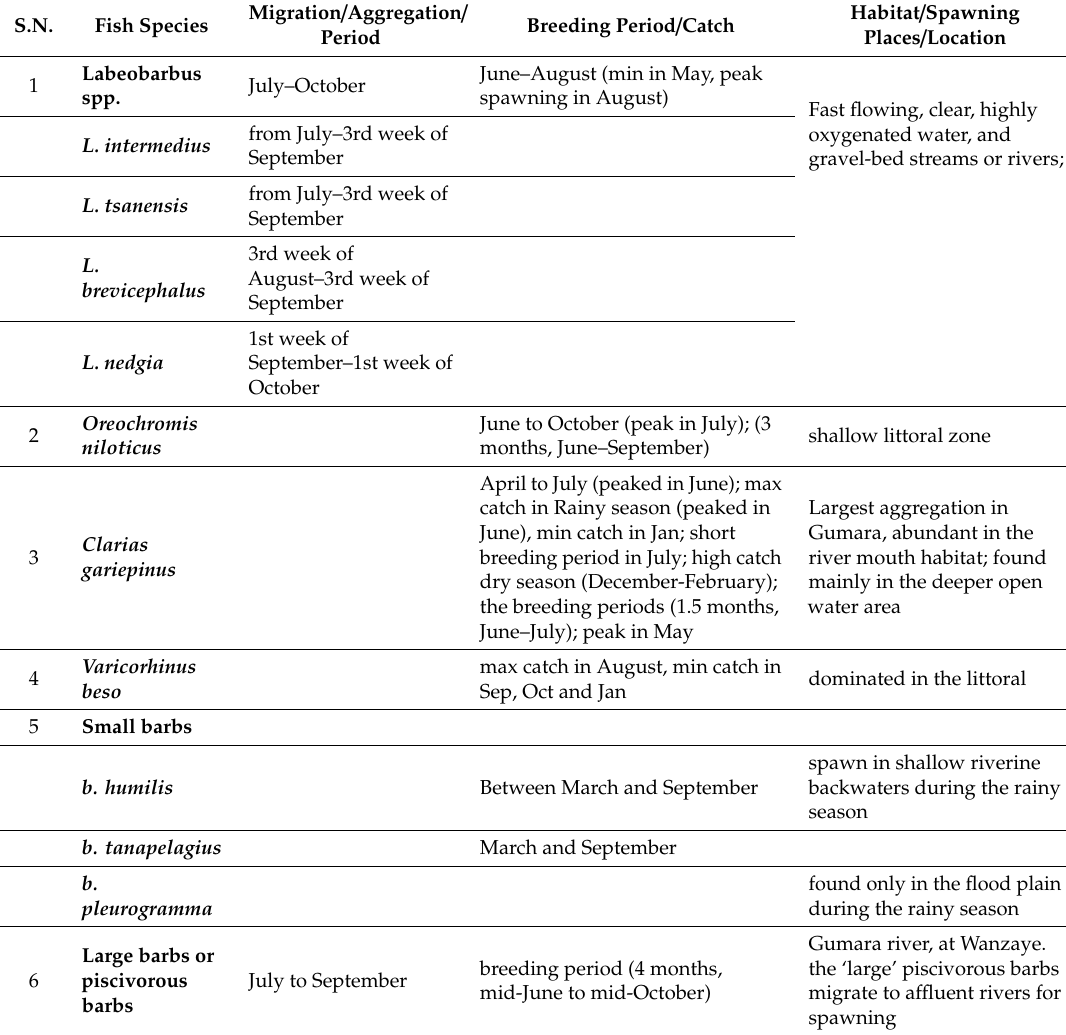
Table 4. Ecological condition of fish species in Lake Tana-Gumara River